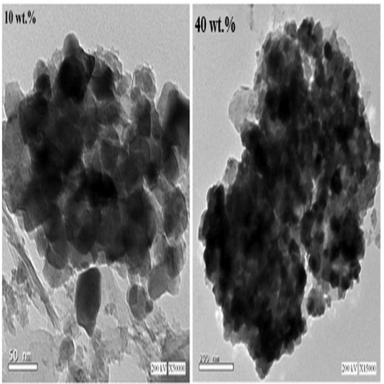
TEM for polyester doped 10% and 40% Ni0.5Zn0.5Fe2O4 nanoparticles.